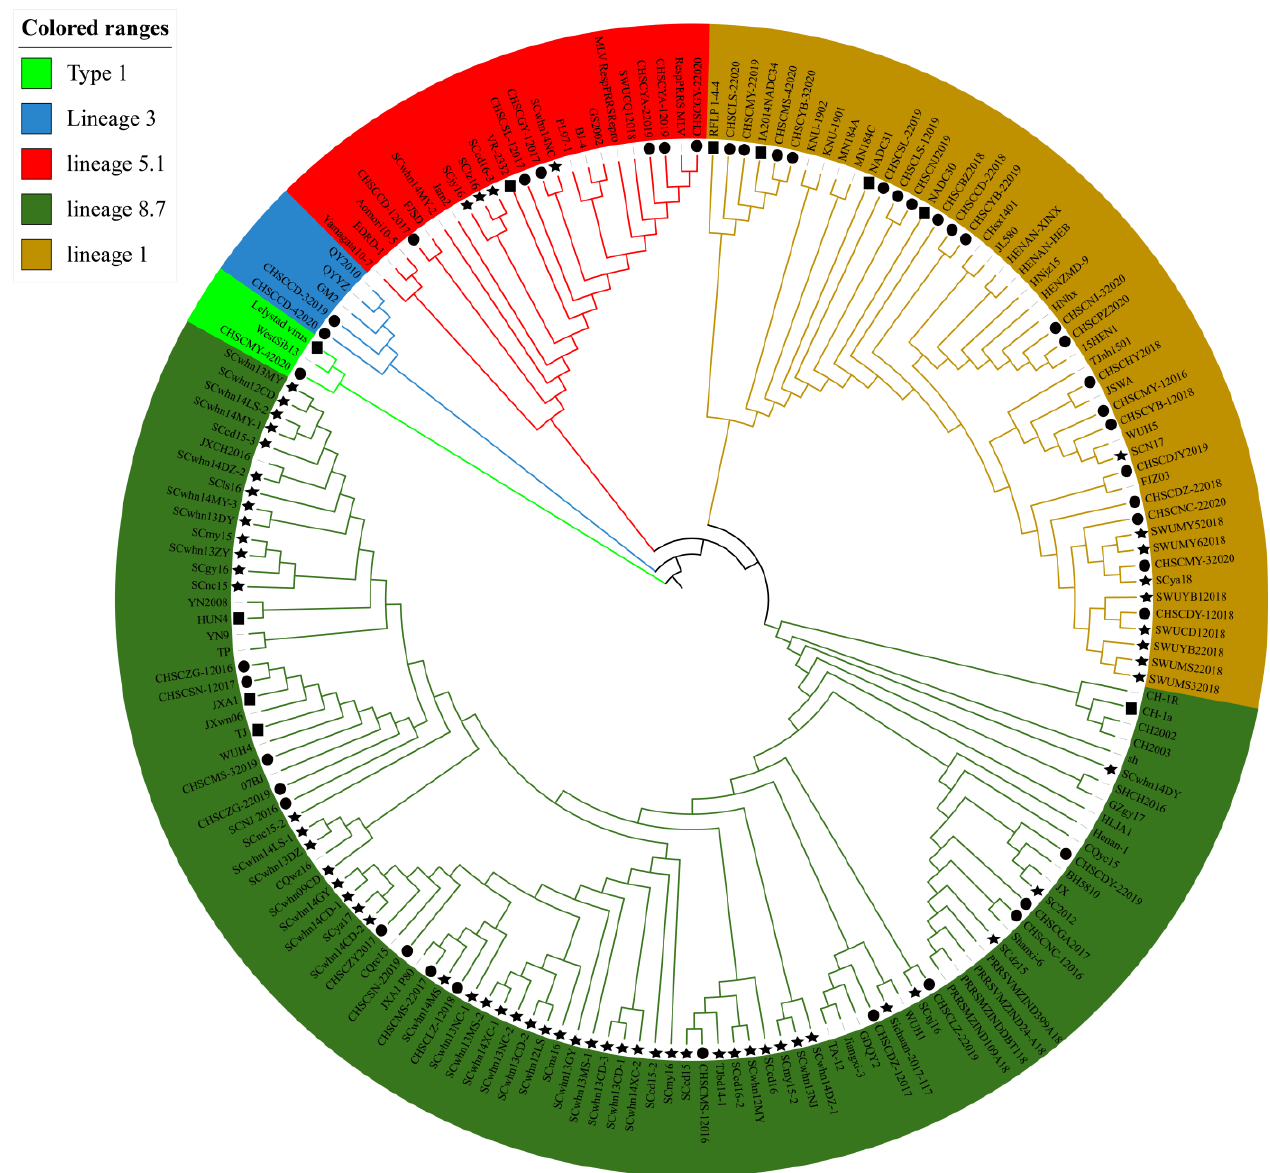
Figure 3. Phylogenetic analysis based on Nsp2. The black dot represents PRRSV strains identified in our study, the black star diagram represents PRRSV strains from Sichuan in Gene bank from 2012 to 2020 and the black square represents PRRSV reference strains. Unmarked are the current prevalent strains from other regions of China or other countries.